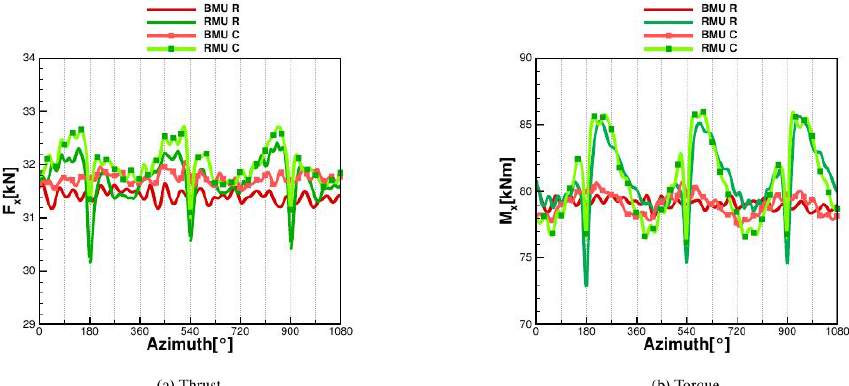
Figure 6. Thrust and torque calculated with CFD at 6.1ms − 1 comparing BMU vs. RMU, both rigid (R) and coupled